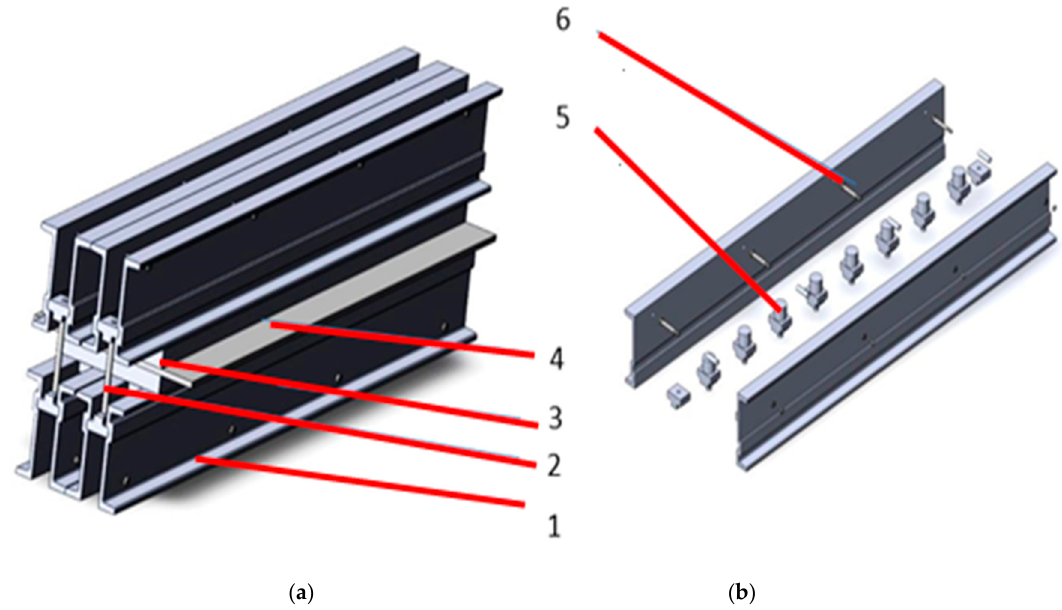
Figure 3. Structural presentation of the vulcanization facility. ( a ) general presentation of the belt vulcanization press; ( b ) presentation of constructive details of the belt vulcanization press. 1—traverse; 2—system for fixation of traverse package; 3—heating plate; 4—conveyor belt; 5—hydraulic pistons for maintaining the pressing pressure; 6—spacers.